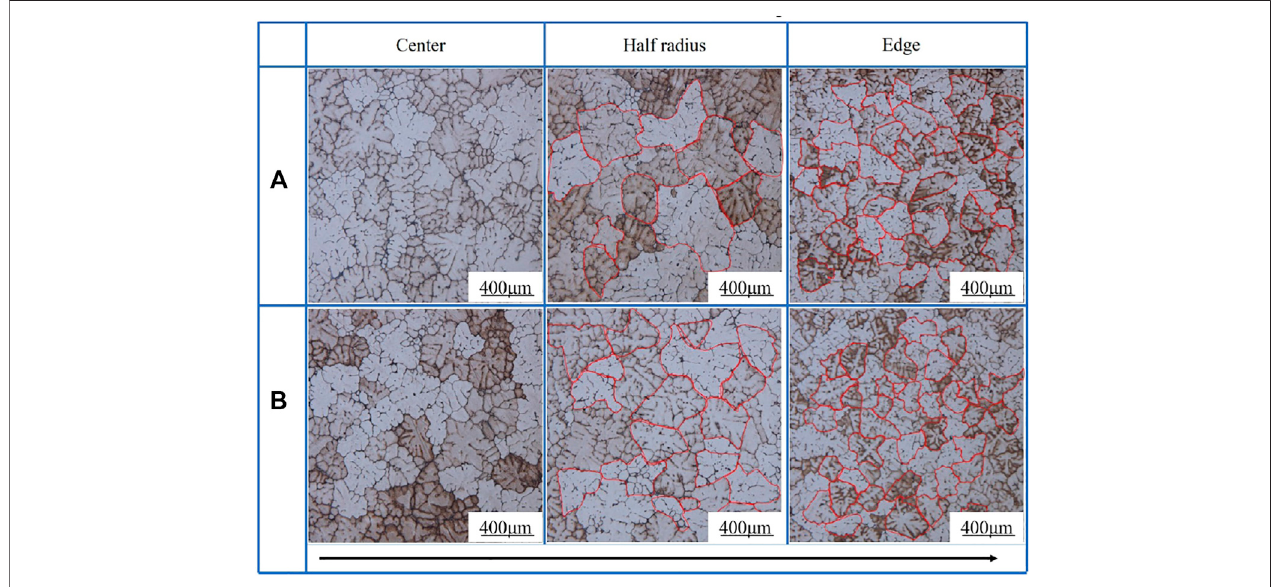
FIGURE 4 | Optical micrographs at the central and half-radial regions and the edge of the ingots treated with (A) DSU and (B) TSU.